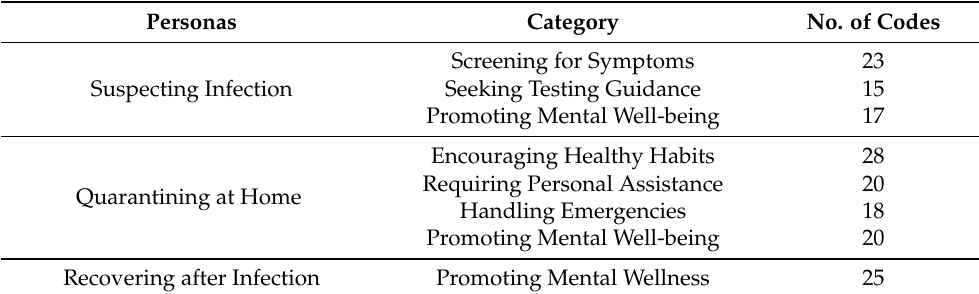
Table 2. Thematic Analysis Results from Study